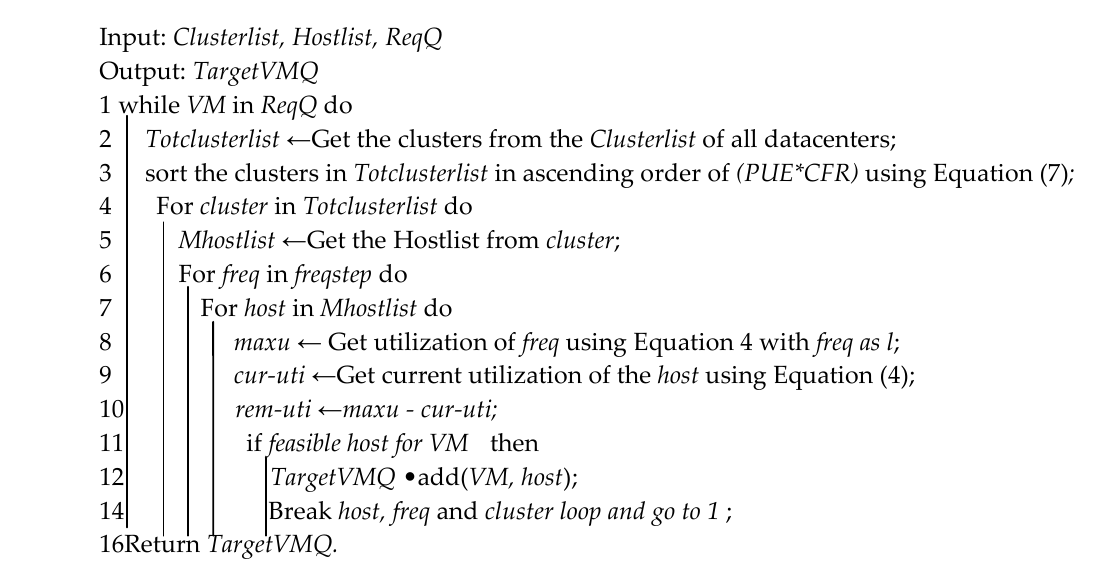
Algorithm 3: C-FFF Carbon-Aware First-Fit Least-Empty VM Placement